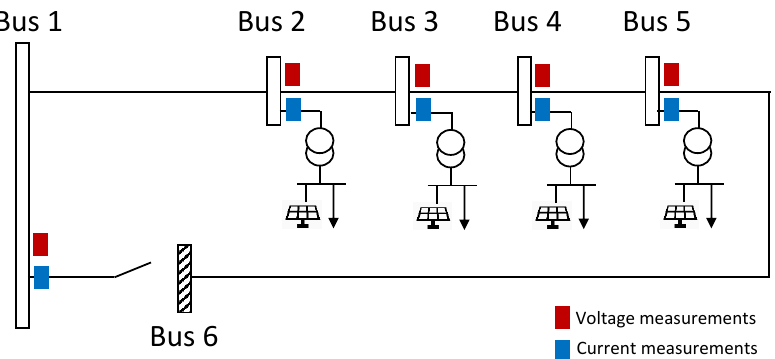
Figure 6. Simplified schema of the medium-voltage network inside the EPFL campus where there are indicated the loads, PV generators and PMU measurements